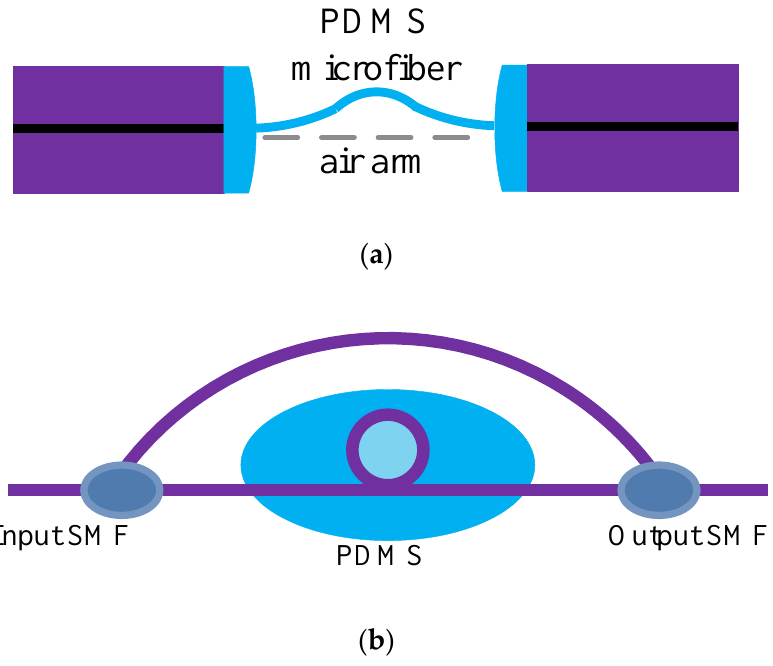
Figure 3. Applications of PDMS and Mach–Zehnder structure: ( a ) Sensor consists of the PDMS microfiber and air arm [25]; ( b ) Sensor consists of a bend arm and straight arm [26].